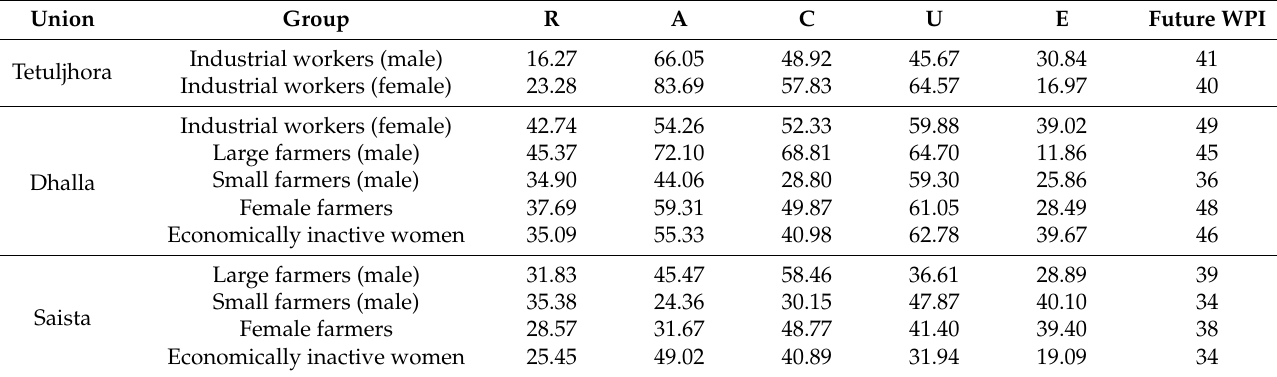
Table 7. Future WPIs for different livelihood groups in peri-urban areas around Dhaka. Union